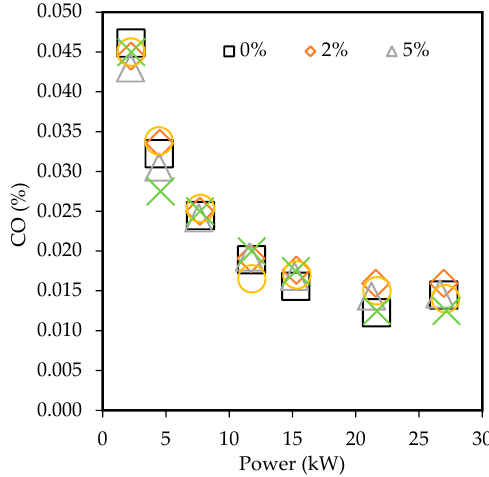
Figure 9. Variations in CO emissions of tested fuels.